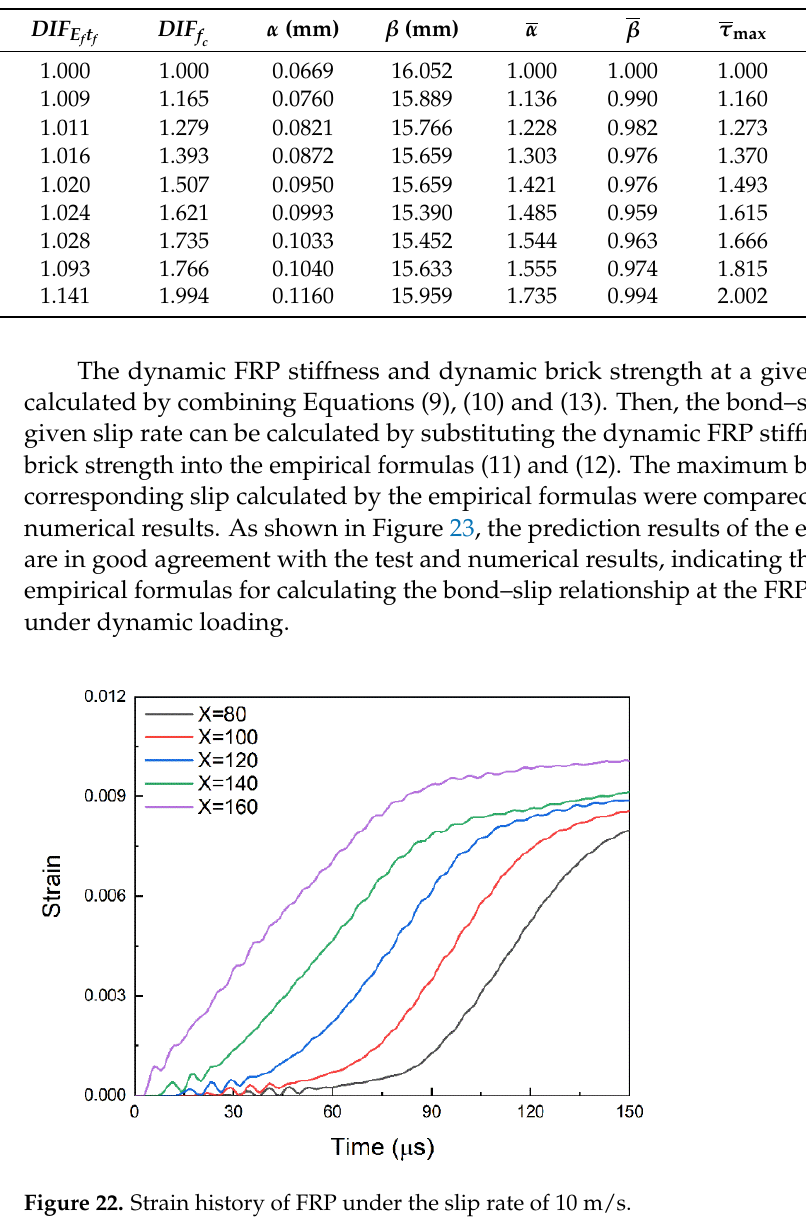
Table 6. Calculation results under different slip rates.